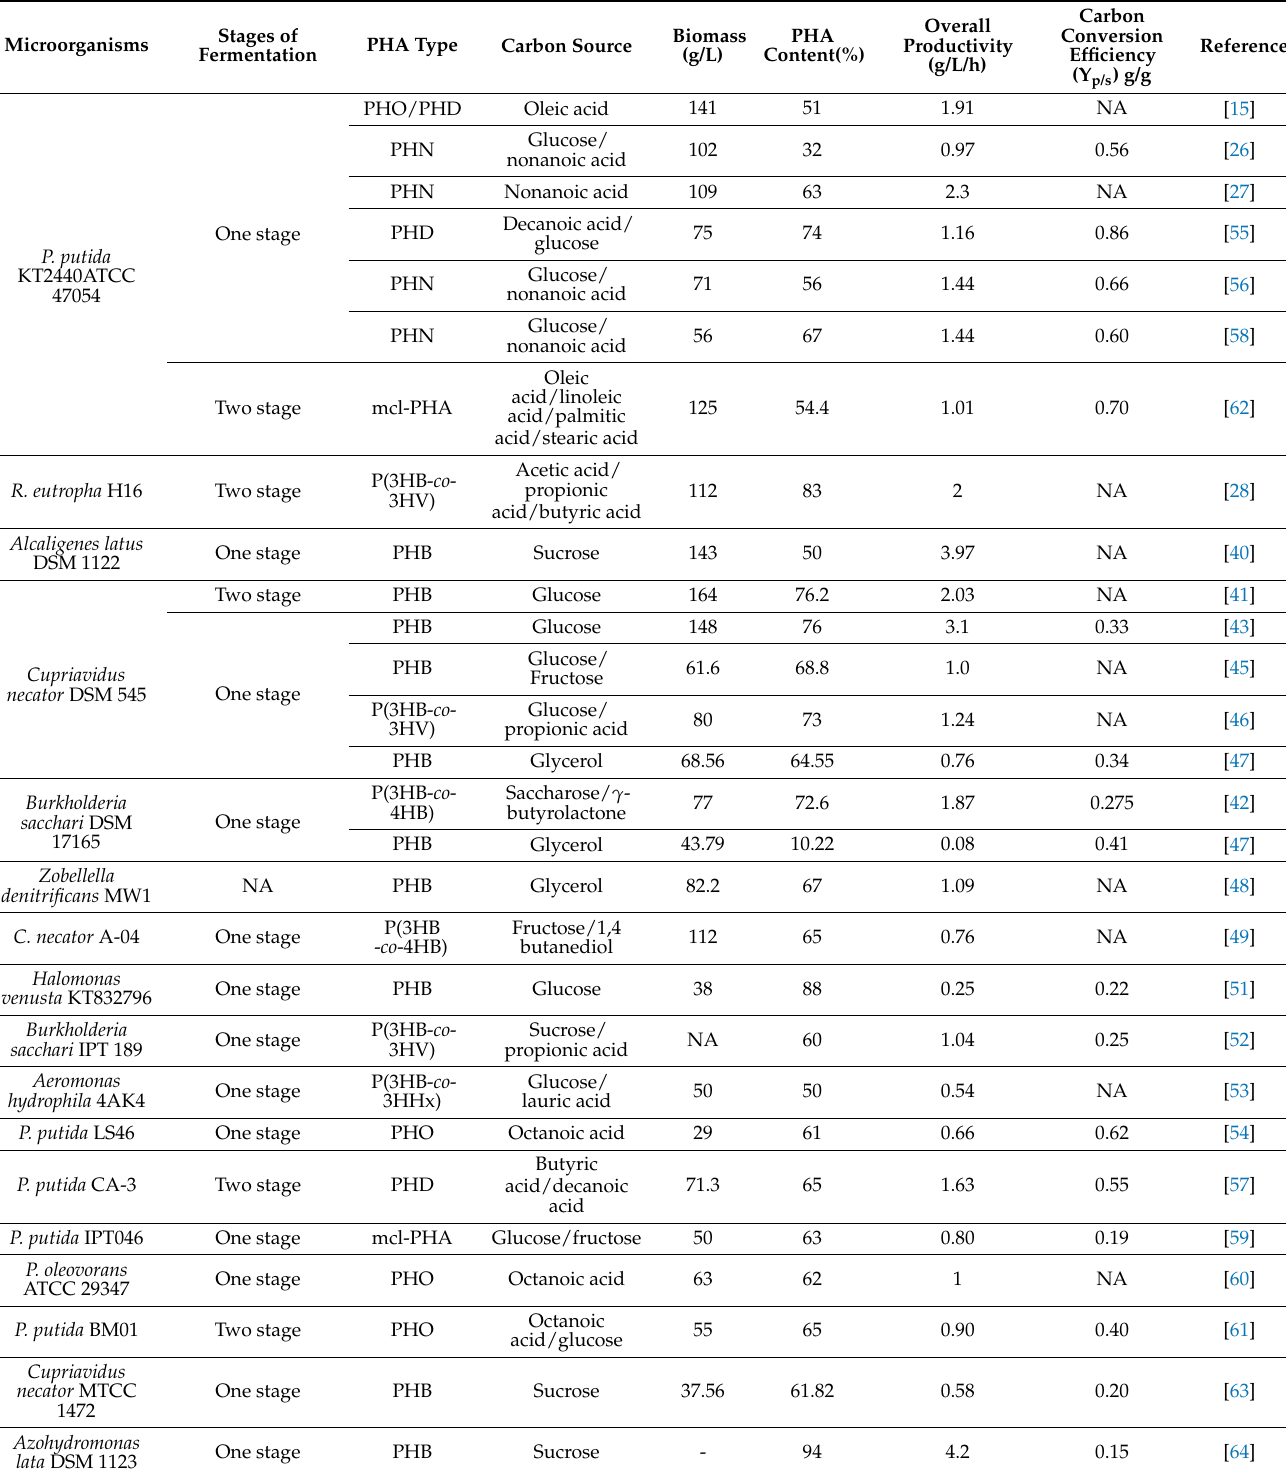
Table 1. PHA production by high cell-density cultivation (HCDC) fed-batch